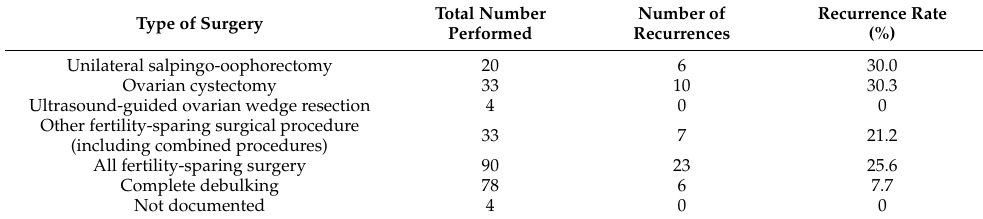
Table 4. Recurrence rate of Borderline Ovarian Tumour following surgical management of primary disease.